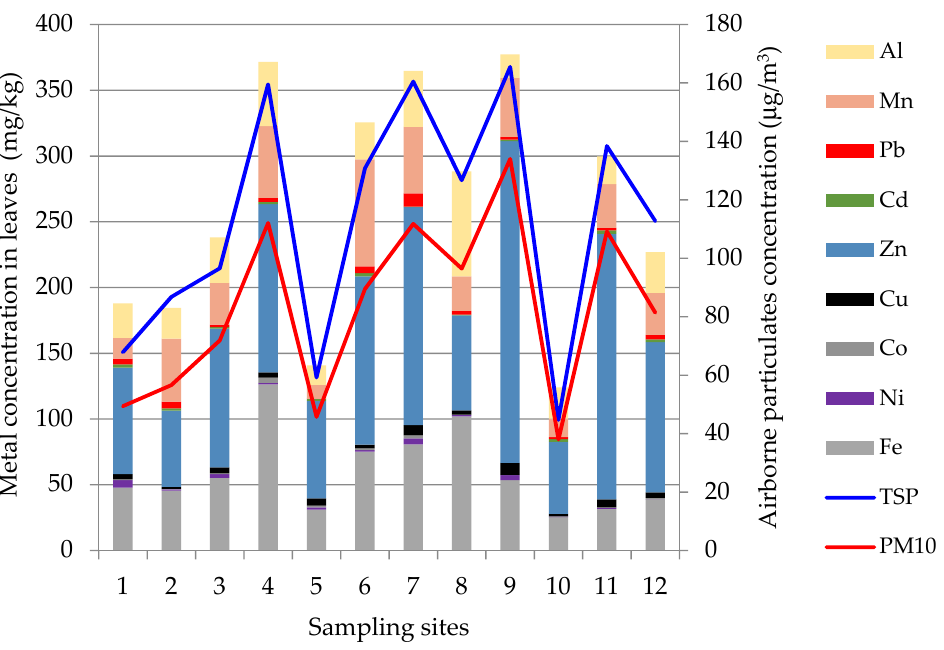
Figure 5. Concentration of metals in poplar leaves (mg/kg) and of TSP and PM 10 ( µ g/m 3 ) in air. The metal accumulation index (MAI) for poplar species from Cluj-Napoca was 1.7,